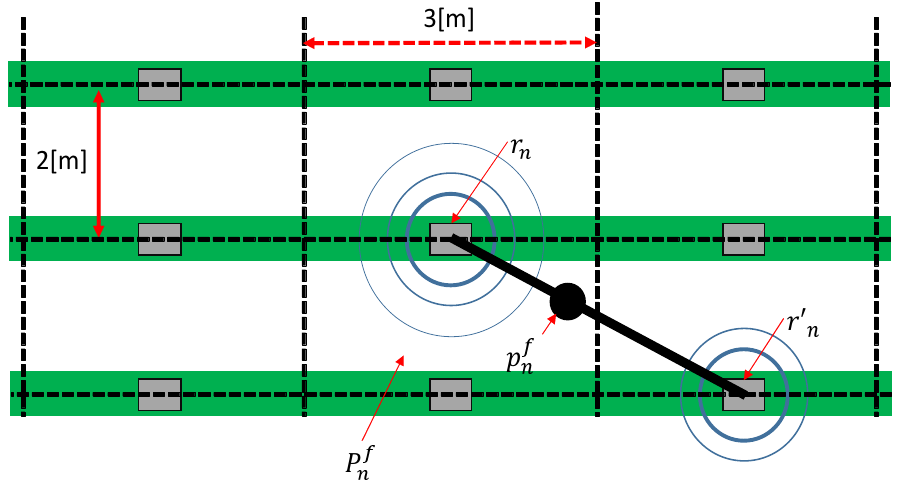
Figure 3. Diagrammatic depiction of the estimation method. First the approximate farm laborer’s position is estimated p f ( n ) with p i